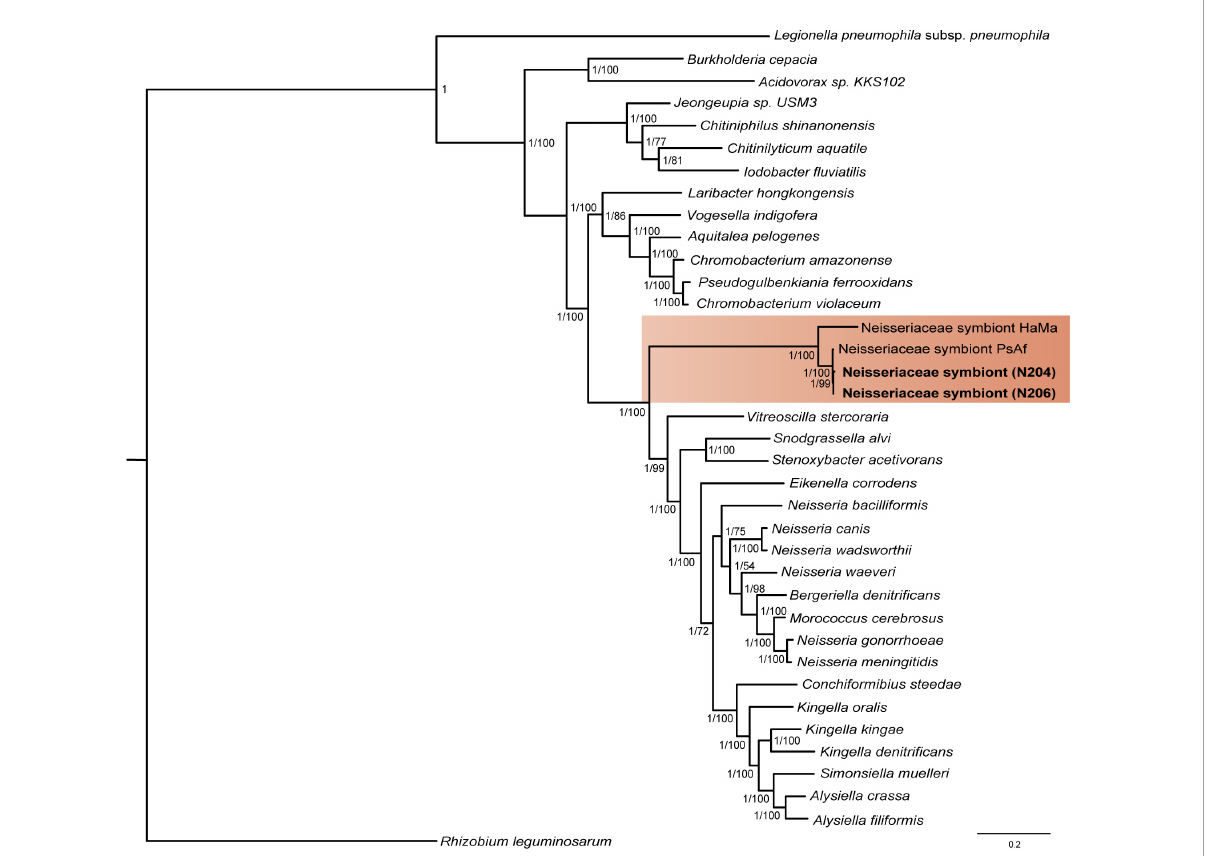
FIGURE4 Clustering of the N206 and N204 symbionts together with the Neisseriaceae-related symbionts from Rihova et al. (2021), indicated by orange background. The tree was inferred by MrBayes (LG + G + I + F model) and PhyML (LG + G + I + F model) from the amino-acid 30-gene “Neisseriales matrix” (4,465 aa), lengths of the branches in the tree of the symbiont correspond to the BI tree results. Values at the nodes of the symbiont tree show posterior probabilities/bootstrap supports.